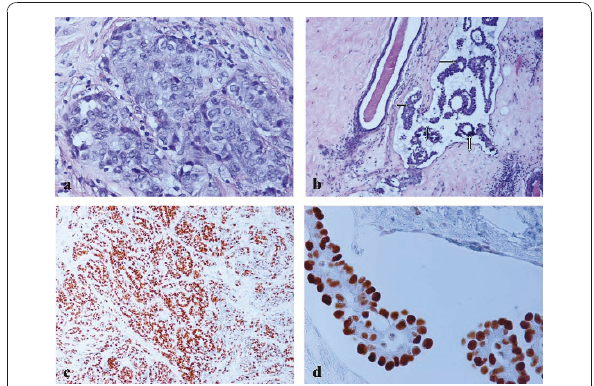
Figure 5 Breast biopsy . a) Nodular infiltration by solid (high grade) adenocarcinoma. (Hematoxylin-eosin, ×400). b) Lymphatic tumor emboli of micropapillary pattern adenocarcinoma (single arrow) and multiple psammoma bodies (double arrow). Ectatic duct is noted in the left side. (Hematoxylin-eosin, ×100). c) Immunohistochemical nuclear TTF-1 positivity of adenocarcinoma with solid